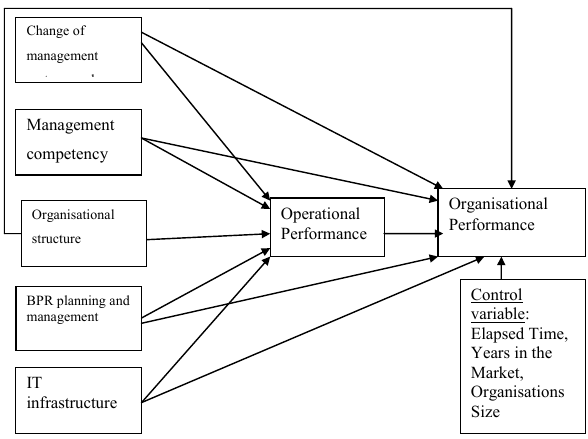
Figure 1: Proposed model for the effects of BPR efforts on performance